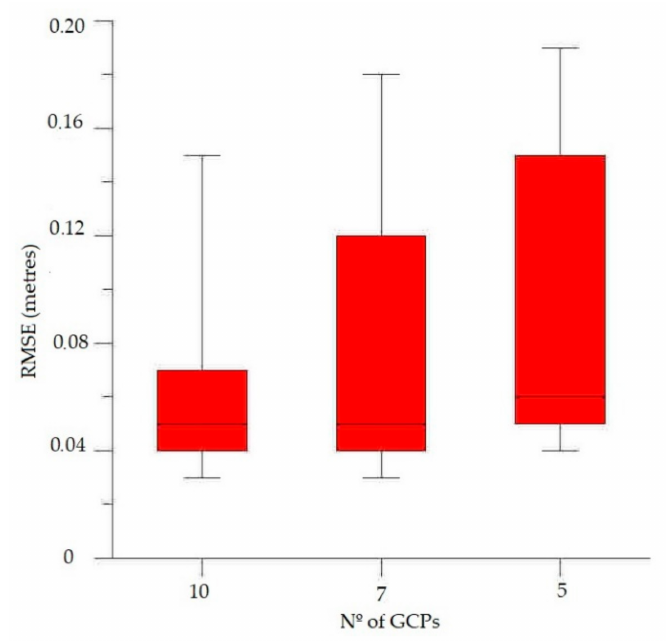
Figure 7. Box-and-whisker plot of the average error based on the GCP